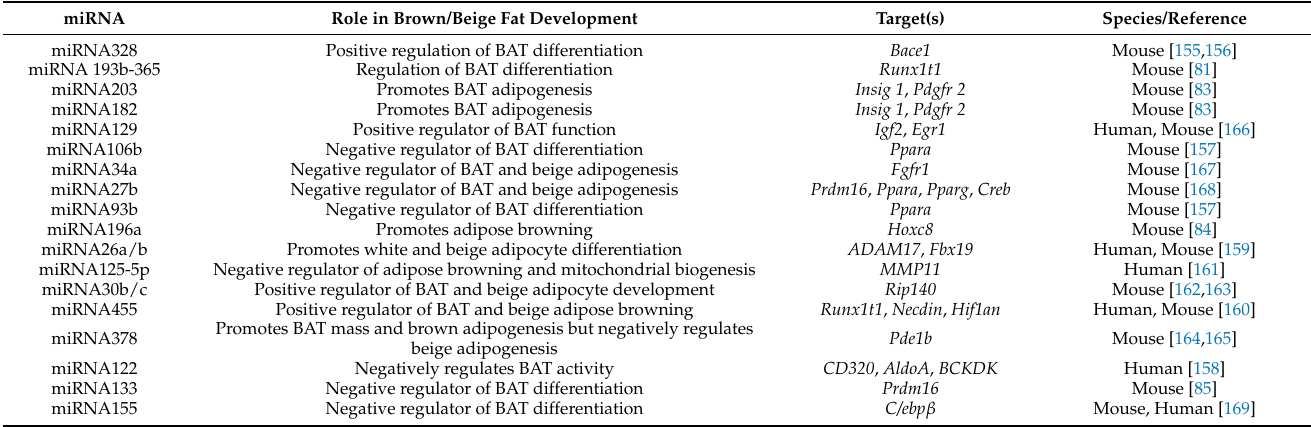
Table 1. MicroRNAs involved in brown/beige fat development and their